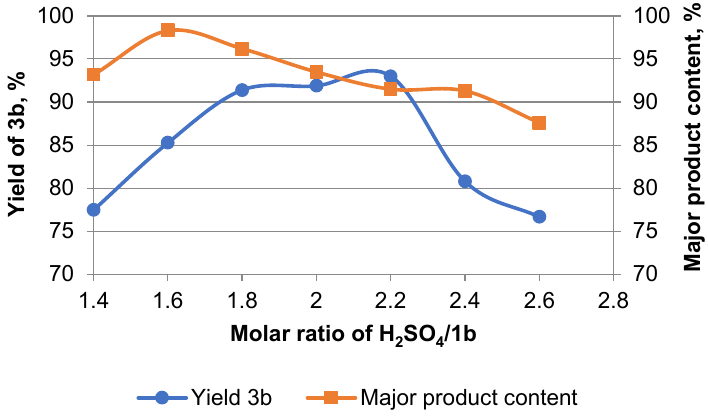
Figure 1. The yield of 3b plotted against the molar ratio of H 2 SO 4 / 1b .